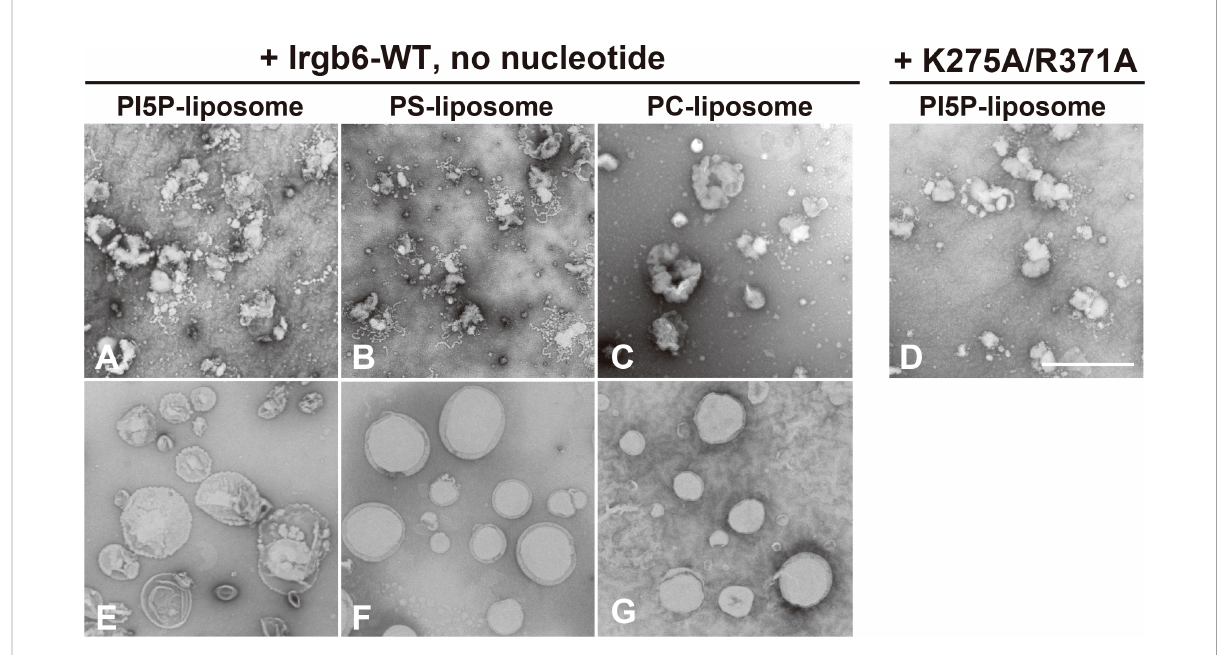
FIGURE 1 Irgb6 deforms PS or PI5P-containing liposomes. Negative stain EM of 10% PI5P-, PS- or PC-containing liposomes (0.1 mg/ml) incubated with 1 m M Irgb6-WT or K275A/R371A (A – D) . Liposome alone were shown (E – G) . Note that remarkable membrane deformation of PI5P- or PS- containing liposomes (A, B) . Scale bar: 1000 nm (A – G)